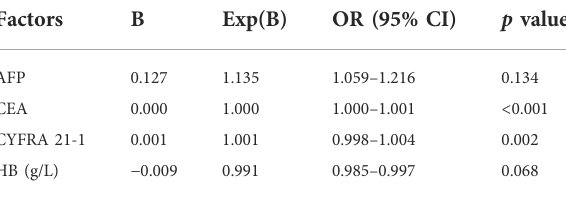
TABLE 3 Risk factors in lung cancer patients with mediastinal lymph node